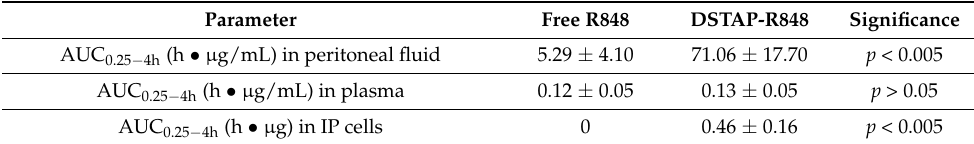
Table 2. AUCs of R848 concentrations displayed in Figure 1.